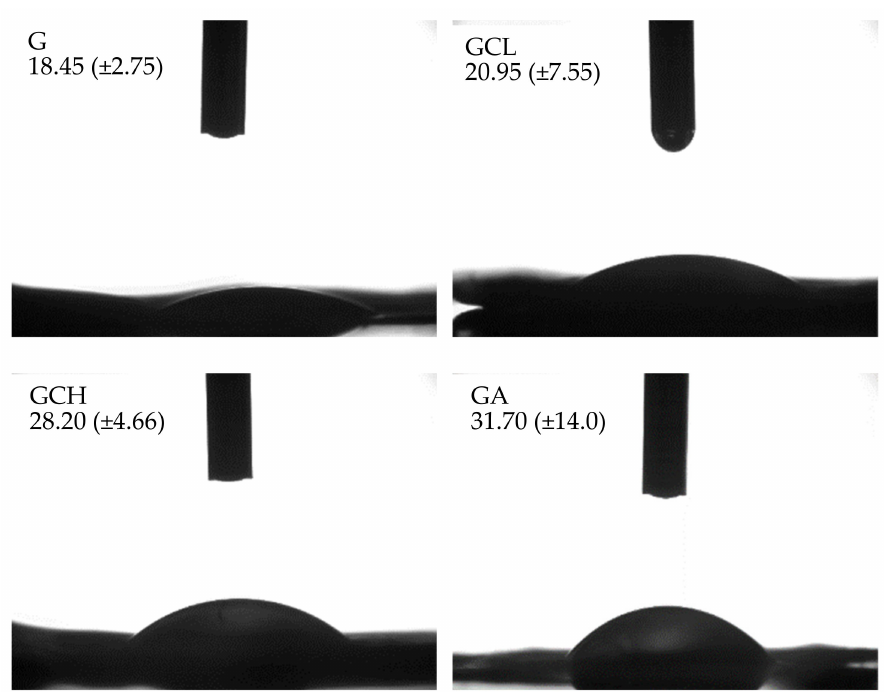
Figure 2. Images of the drop onto the scaffold surface after 1000 ms. In each image the value of the contact angle is reported (mean values ± s.d.; n = 3).